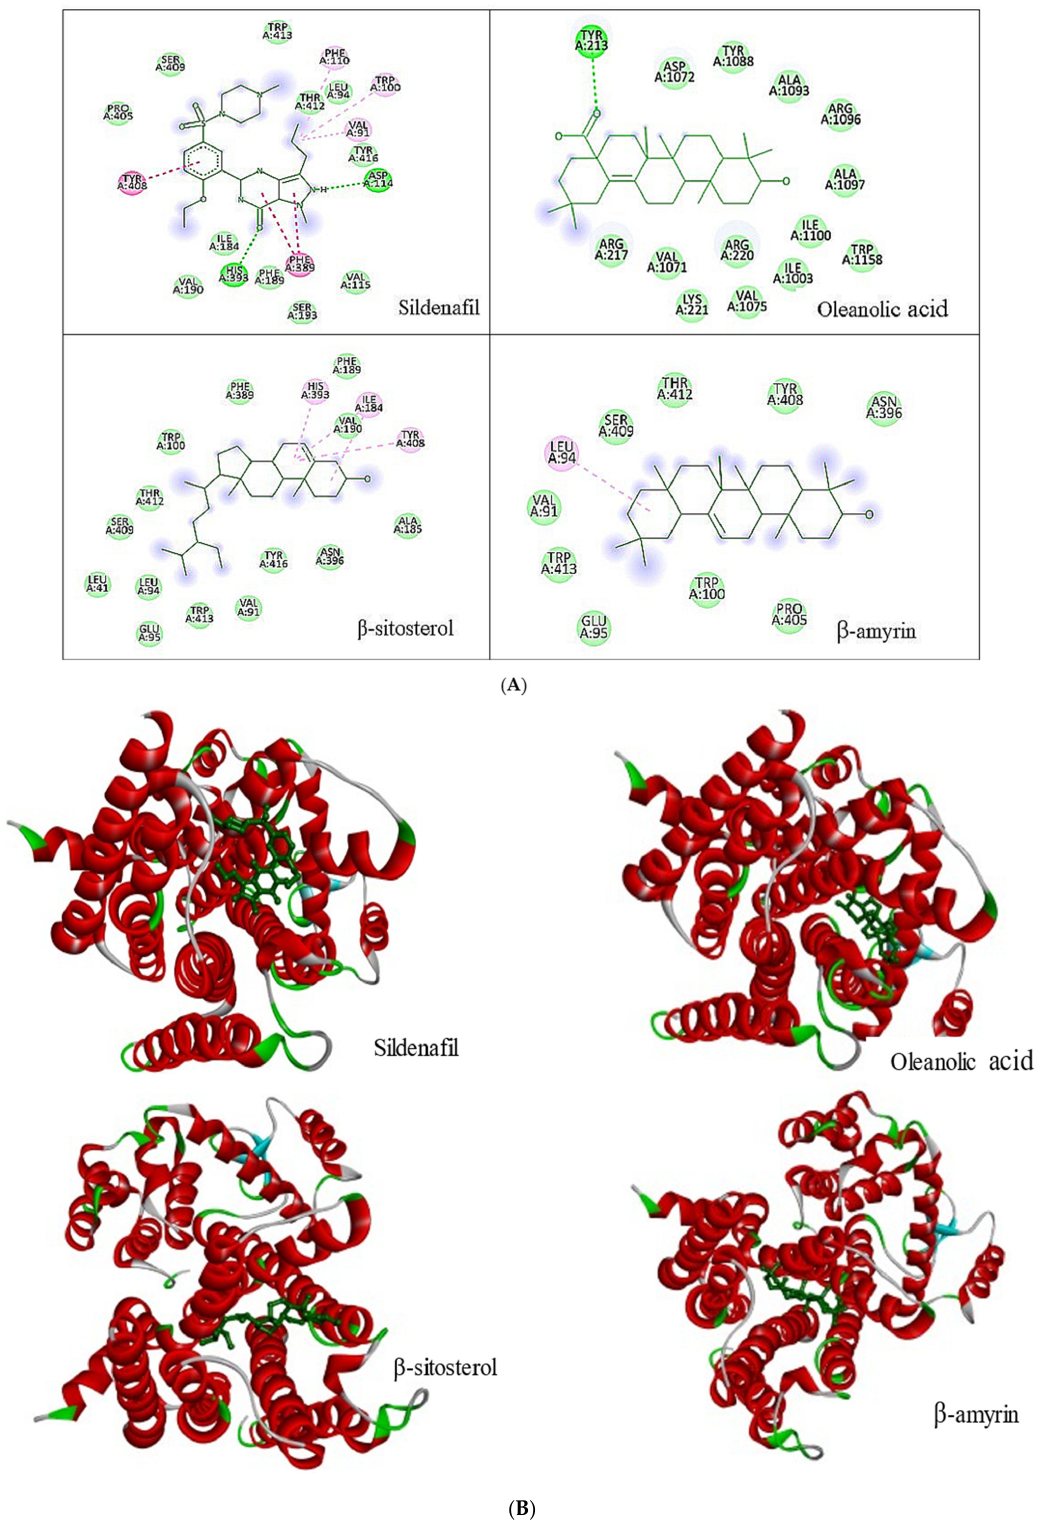
Figure 2. ( A ) Two-dimensional representation of the docked conformation of dopamine R 2 with ligands obtained after docking. Green dashed lines represent conventional hydrogen bonds with the interacting amino acid residues. Pink lines indicate interactions between hydrophobic (alkyl–alkyl, π –alkyl, or π – π ). ( B ) Three-dimensional representation of the docked conformation of dopamine R 2 docked conformation of ligands obtained after Glide XP docking.